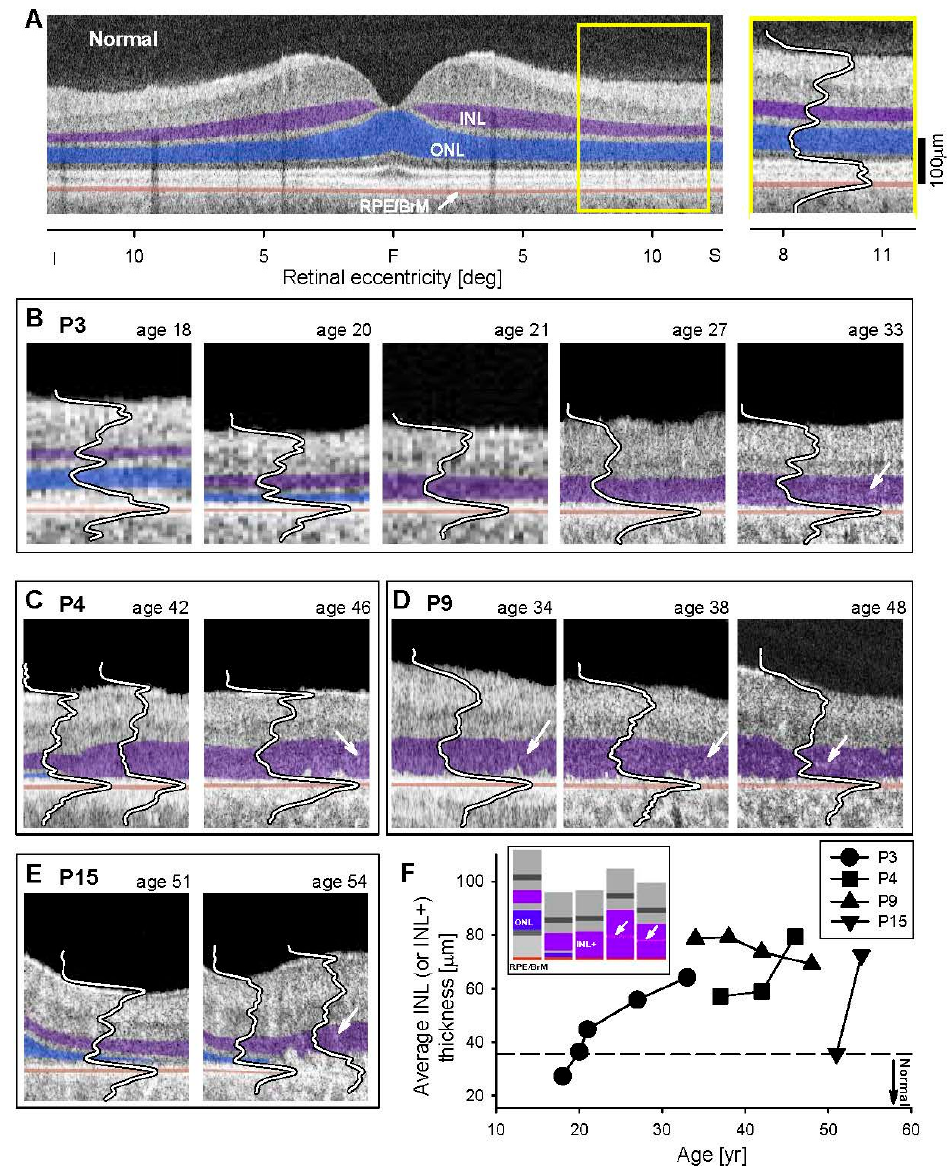
Figure 5. Progression of inner retinal structural abnormalities in EYS patients. ( A ) Cross-sectional OCT along the vertical meridian through the fovea in a representative normal retina with inner nuclear layer (INL), outer nuclear layer (ONL), and RPE/BrM (retinal pigment epithelium/Bruch’s Membrane) colorized for visibility with purple, blue, and orange, respectively. Enlarged view of a 5° wide perifoveal region in the superior retina (marked as a yellow rectangle on the unmagnified scan) with an overlaid longitudinal reflectivity profile (LRP). ( B – E ) Corresponding sections in four EYS patients sampled serially. A thinned ONL layer was sometimes present at early visits (P3, P4, P15) but was not detectable on later visits which showed abnormally thickened INL (termed INL+). White arrows point to hyperreflectivity within the INL+. ( F ) Average INL (or INL+) thickness is plotted as a function of age for four patients; serial data are connected by lines. Dashed line represents upper limit (+2SD) of normal INL thickness. Inset (upper left corner of graph) is a schematic of the postulated changes in laminar architecture over the disease course. F, fovea; S, superior; I, inferior retina. INL+, designation for abnormal inner retinal layer noted when ONL is no longer discernible.